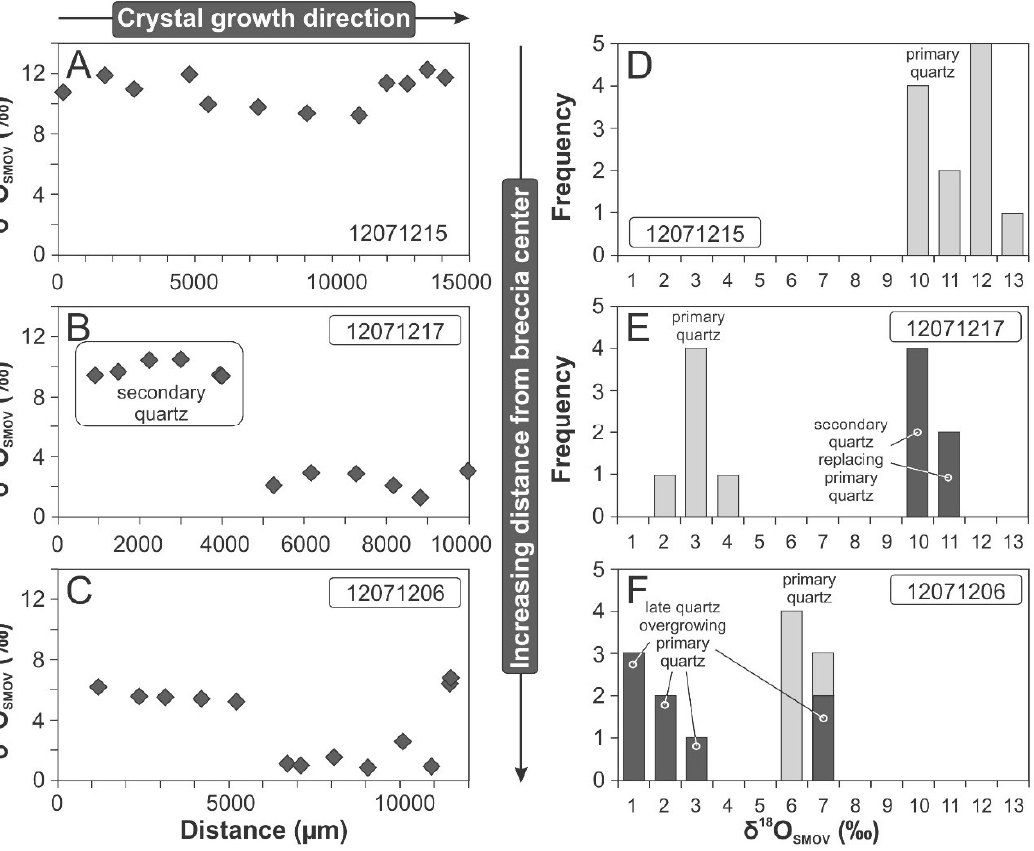
Figure 11. ( A – C ) Variation profiles of δ 18 O values across three quartz crystals (see also Figure 8 for location of the SIMS measurements within the crystals). ( D – F ) Histograms of measured δ 18 O values shown in the profiles ( A – C ). Grey bars are δ 18 O values related to major quartz crystal growth (primary quartz). Black bars represent quartz δ 18 O values affected by late- to post-crystallization processes.